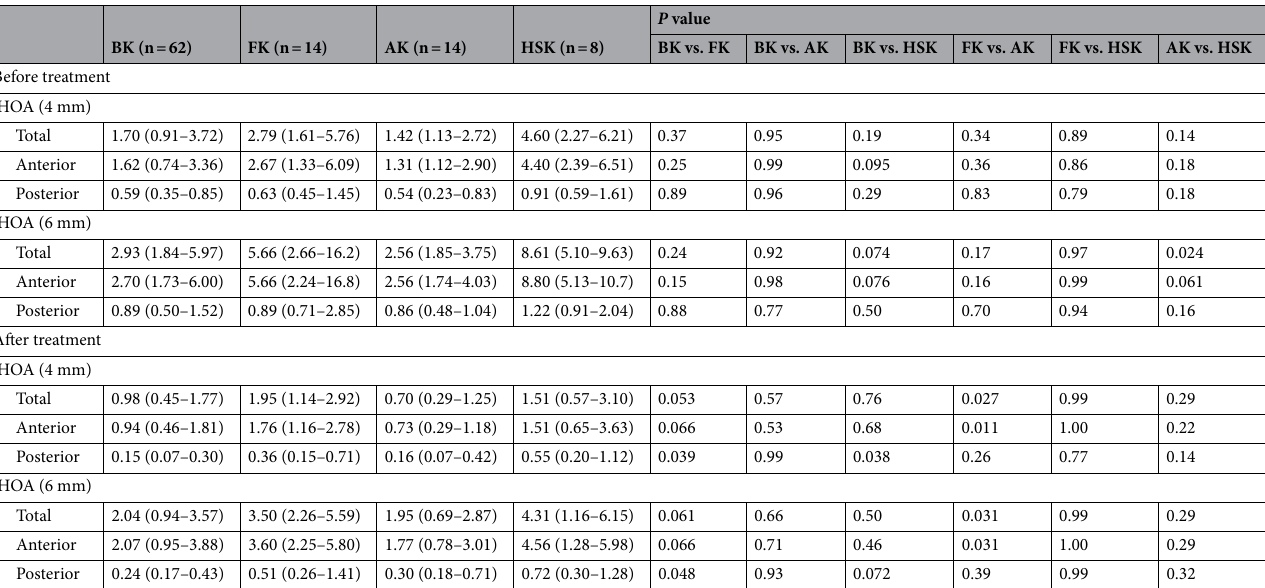
Table 3. Corneal higher-order aberrations before and after treatment for each of the aetiologies. The values are presented as median (interquartile range) (μm). P values were compared among each aetiology using the Steel–Dwass test for non-parametric multiple comparison. AK Acanthamoeba keratitis, BK bacterial keratitis, FK fungal keratitis, HOA higher-order aberration, HSK herpes simplex